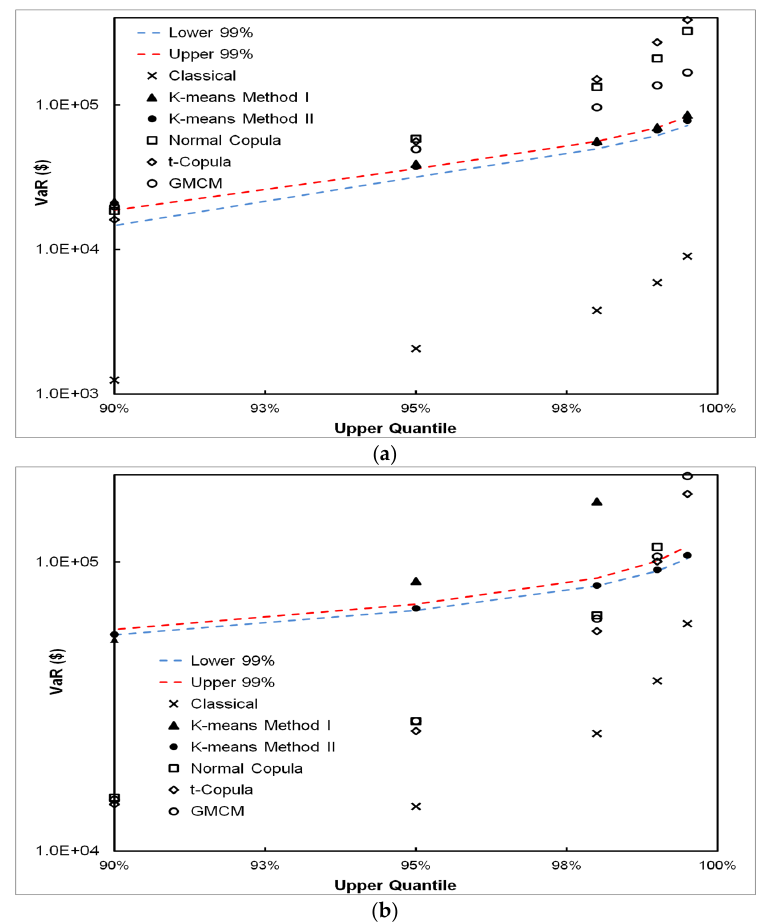
Figure 7. VaR estimates by the classical, DPFS and CPFS methods for the simulated Scenario (I) ( a ) and Scenario (II) ( b ); DPFS Methods (I) and (II) perform comparable to true VaR while the classical method underestimates the VaR.